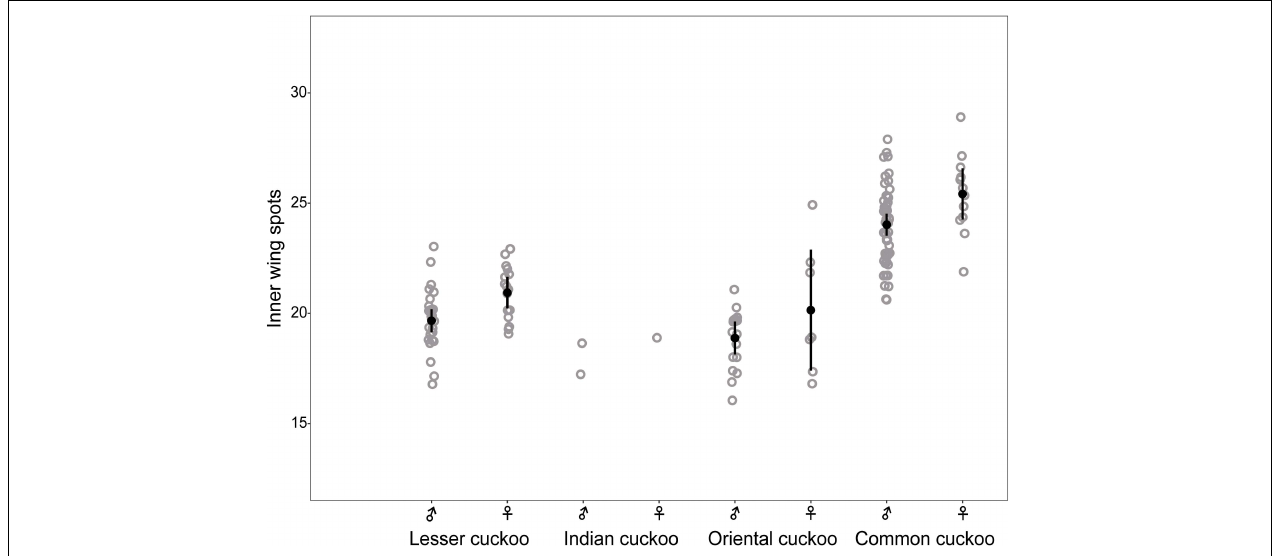
FIGURE 5 | Comparison of the number of inner wing spots according to sex and species among the four Cuculus cuckoos. Each dot indicates the total number of white spots located on the three primaries (p9, 8, 7) of the right wing. Black dots with vertical bars indicate mean values with its 95% confidence intervals.